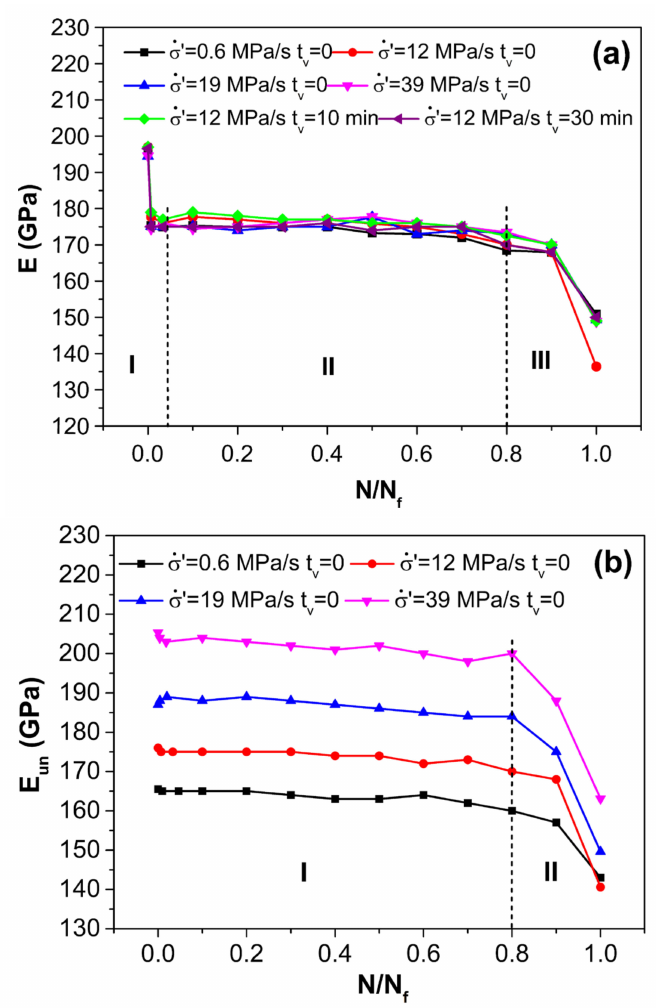
Figure 7. Elastic modulus of ( a ) loading and ( b ) unloading during the entire life under di ff erent unloading